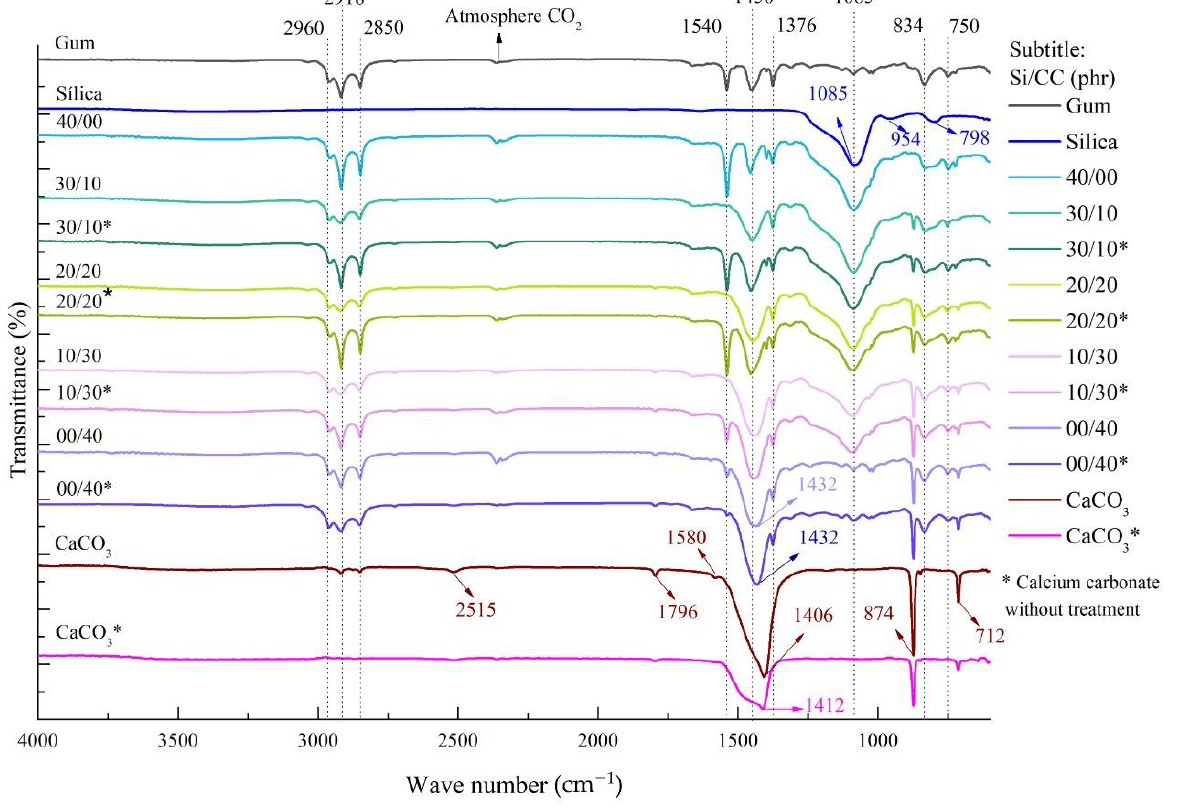
Figure 12. FTIR spectroscopy in ATR mode (4 cm − 1 spectral resolution, DTGS detector using 32 scans, and analyzed over a zinc selenide, ZnSe, window) of the NR hybrid composites with silica (SiO 2 + Si69 ® ) and calcium carbonate (CaCO 3 ) treated with 2% Chartwell ® and the hybrid composites with silica (SiO 2 + Si69 ® ) and untreated calcium carbonate (CaCO 3 ). Gum and treated and untreated fillers in pure form were included as reference points. * untreated calcium carbonate.